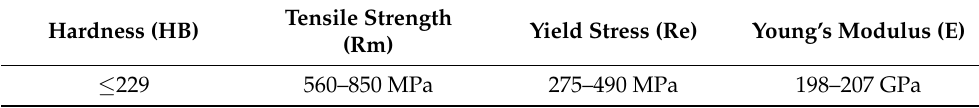
Table 2. Properties of C45